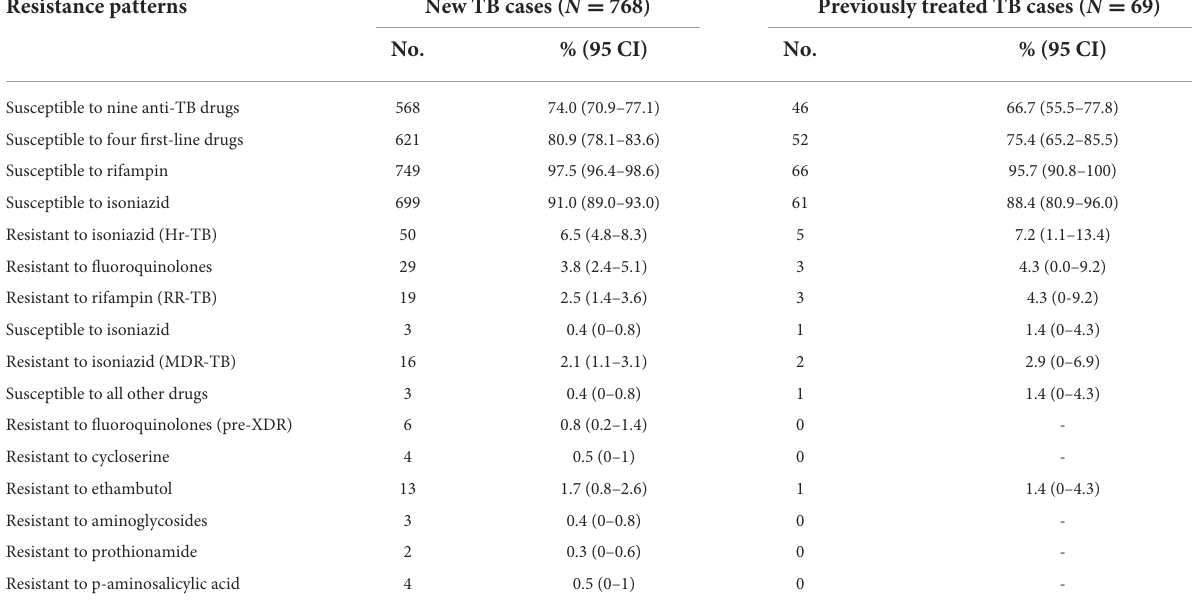
TABLE 2 Drug resistance patterns of eight anti-TB drugs in Zhejiang Province, 2018. Resistance